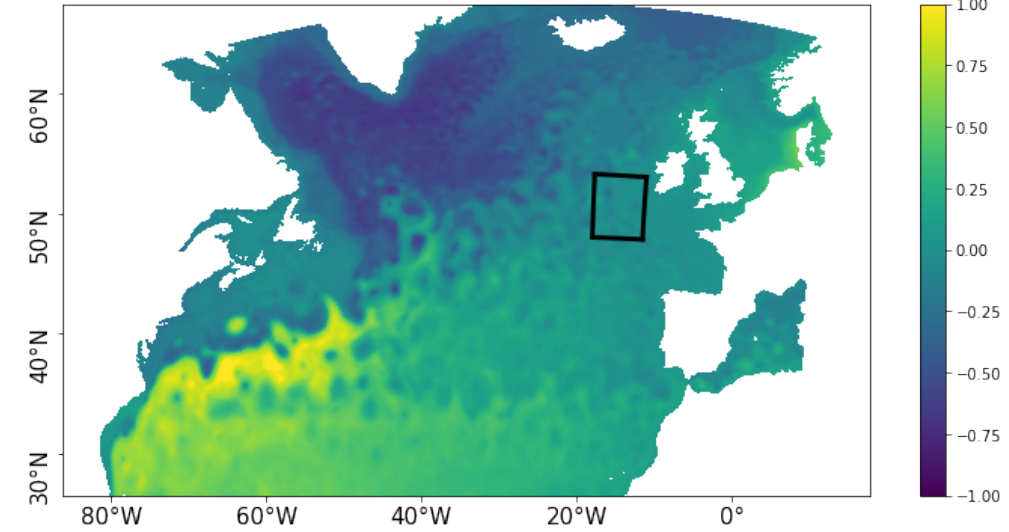
Figure 1. The OSMOSIS region (black box) in an sea surface height (SSH) field (in meters) produced by the NATL60